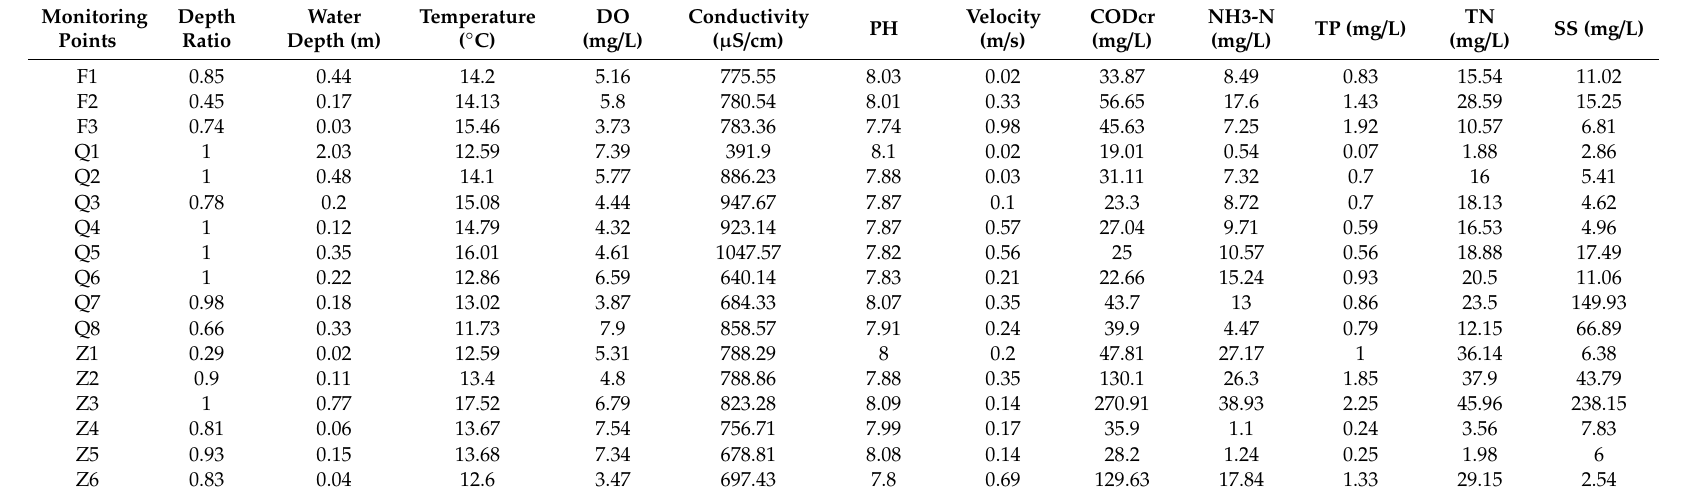
Table 1. The mean of original data in the Qingshui and Fenghuang streams from December 1, 2018 to January 30,